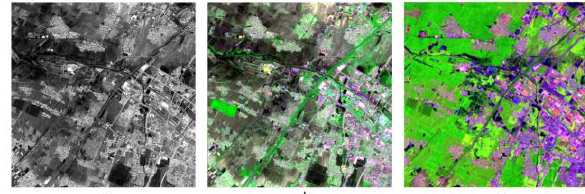
Figure 3. The classification results of the first dataset. (a) is the reference classification result generated through a precise manual interpretation on ALOS fusion images, (b) is the classification result only using ALOS image, and (c) is the classification result combining the ALOS and TM images.